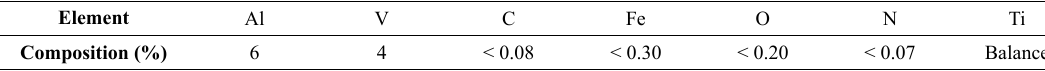
Table 1. Chemical composition of Ti6Al4V alloy. 22